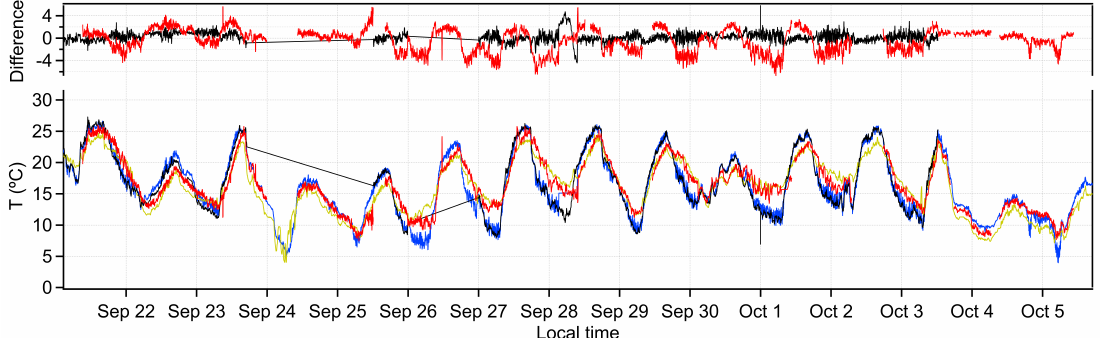
Figure A1. The fitted path-averaged temperature over 2 weeks at 5min intervals (red) compared to the measured air temperature from a rooftop anemometer located near the telescope (blue), a second thermistor temperature sensor also located on the roof but 100m away (black), and a third rooftop temperature ∼ 2.2km away at the NCAR Mesa facility (gold). Top panel: the difference between the two rooftop temperatures (black) agrees to within 1 ◦ C, but the difference between these rooftop sensors and fitted path-averaged temperature (red) shows larger 2–4 ◦ C diurnal differences, indicating it is not sufficient to measure the temperature at one “end point” of the open path. In fact, the path-averaged temperature agrees better with the more distant but higher-elevation temperature sensor located at the NCAR Mesa